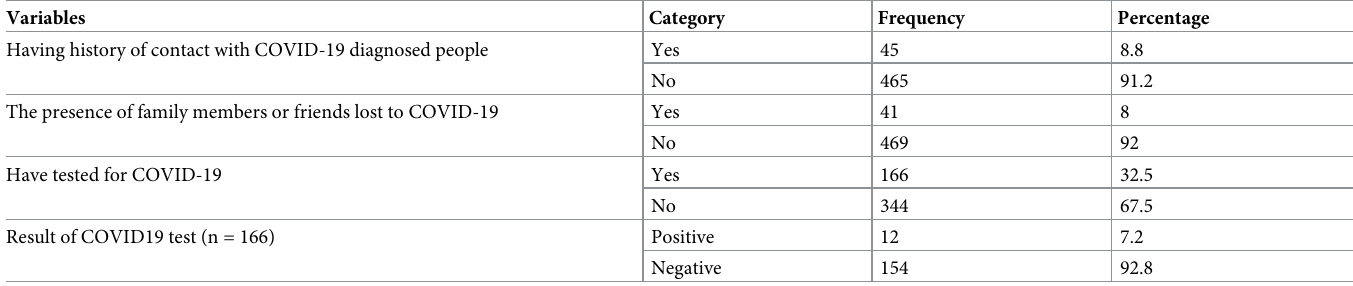
Table 3. Participants’ experience with COVID-19 among pregnant woman attending antenatal care clinic at Gondar town, Northwest Ethiopia, 2021 (n =